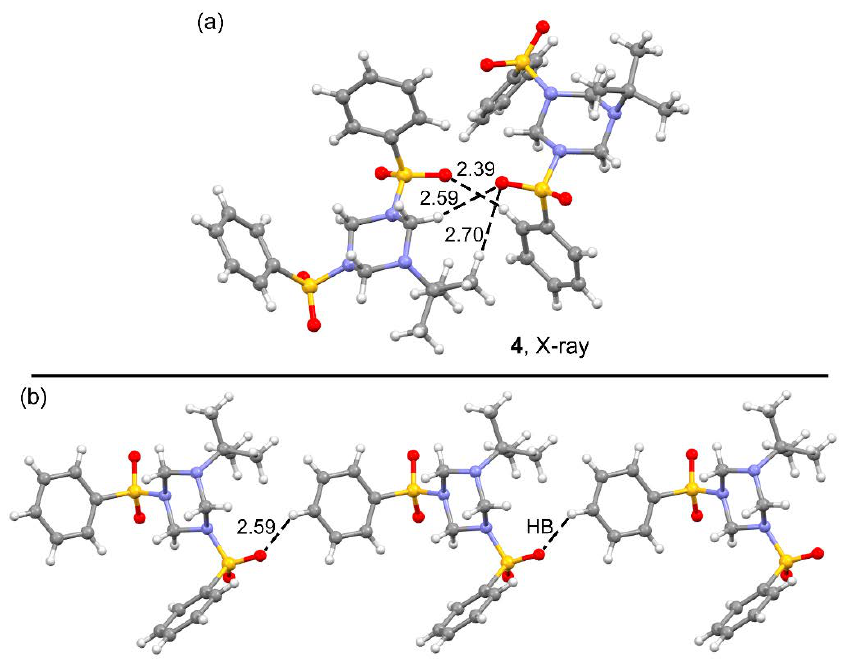
Figure 5. ( a ) Self-assembled dimer of compound 4 . ( b ) 1D supramolecular chain in 4 . Distances in Å.